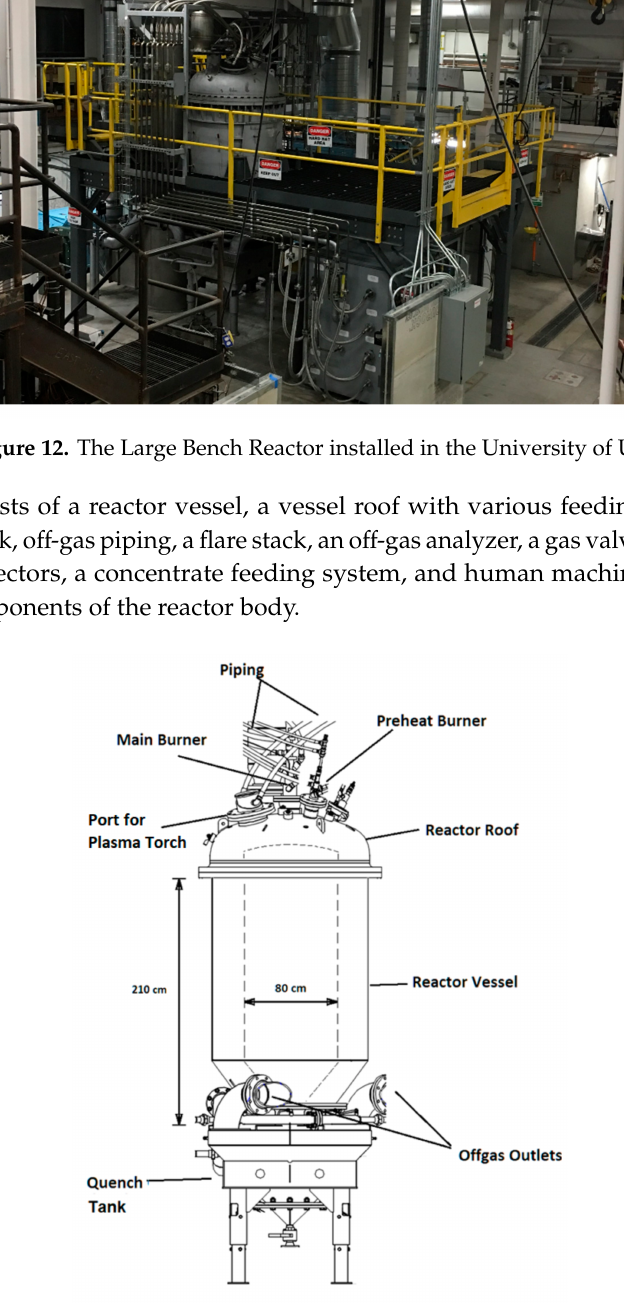
Figure 13. Schematic diagram of the Large-Scale Bench Reactor